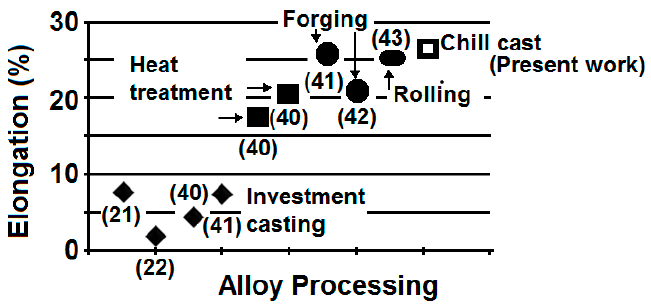
Figure 17. Percent elongation of Co ‐ alloys as a function of alloy processing.